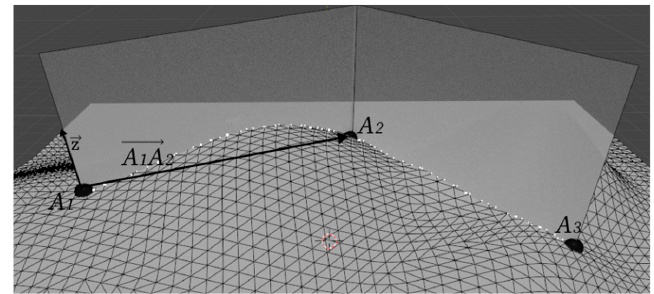
Figure 4. A triangulation model of a seabed surface. tical axis and the obtained triangulation surface in this CS, first, the triangle currently in- tersected by the axis (Equation (2)) should be found among all g triangles. For this, the Möller–Trumbore algorithm [38] is used. Based on the coordinates of the point , V V V of all g triangles, this algorithm identifies the k th , and the vertices vector 2 k triangle through which the axis (Equation (2)) passes. In this case, the coordinates of the point